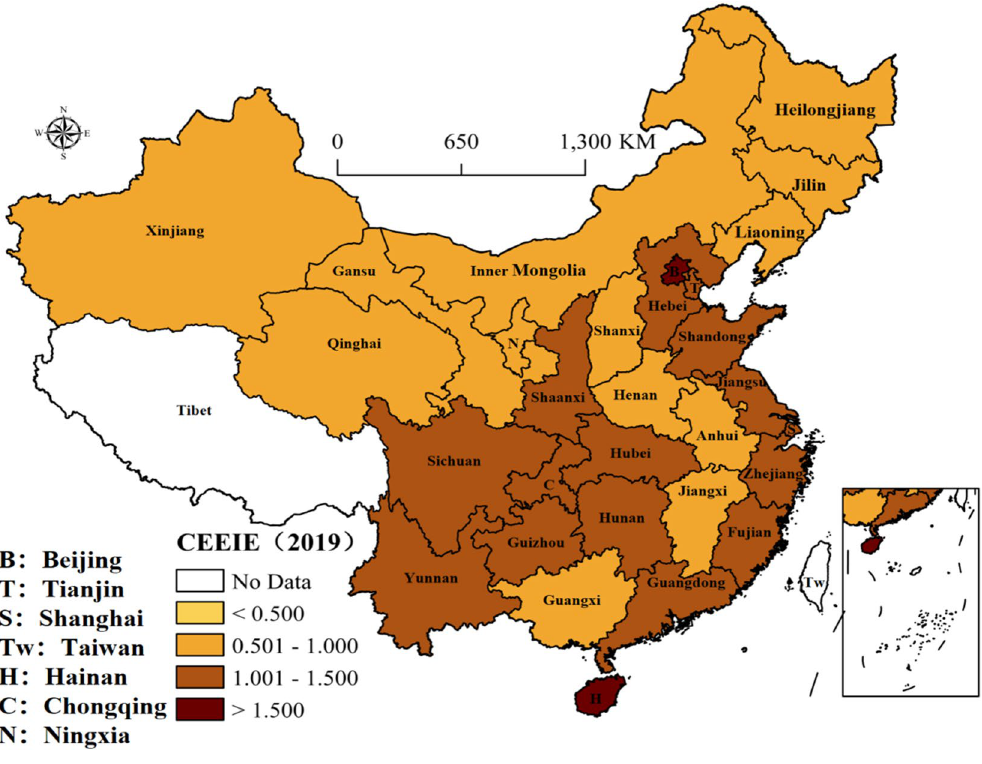
Figure 5. The distribution of CEEIE in 2019 (prepared by KL in ArcGIS Pro, https:// www. esri. com/ zh- cn/ arcgis/ produ cts/ arcgis- pro/ resou rces).